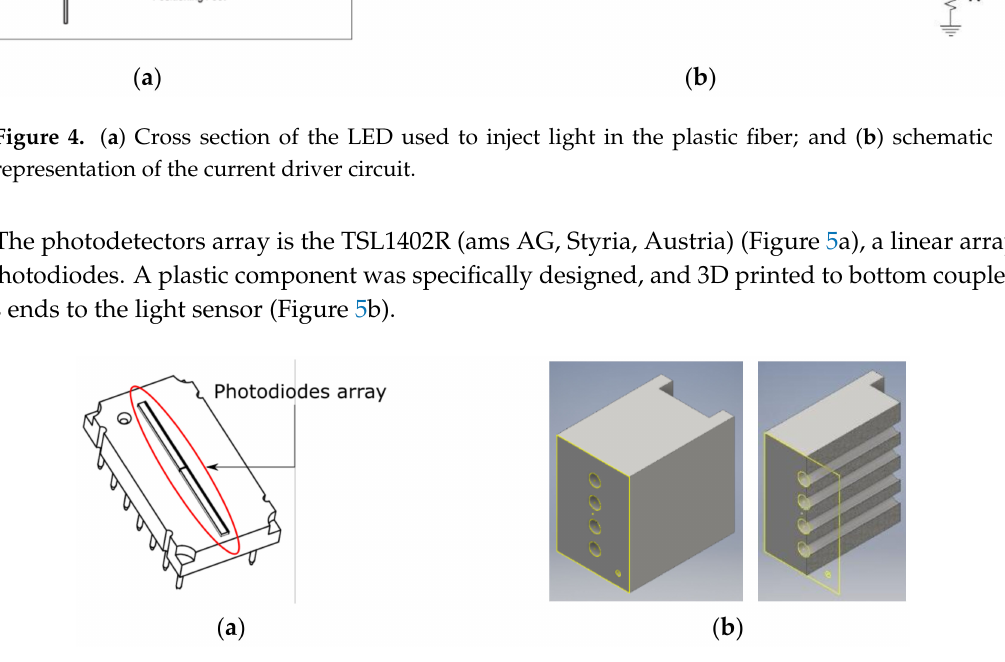
Figure 5. ( a ) Photodetectors array TSL1402R; and ( b ) 3D model of the fiber holder, entire piece (left) and cross-section